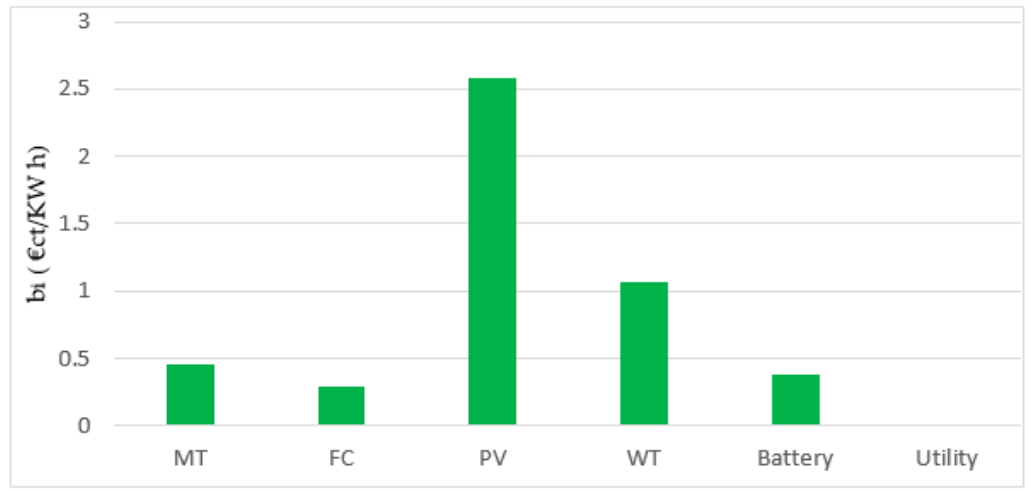
Figure 8. The power limits of the installed DG units .